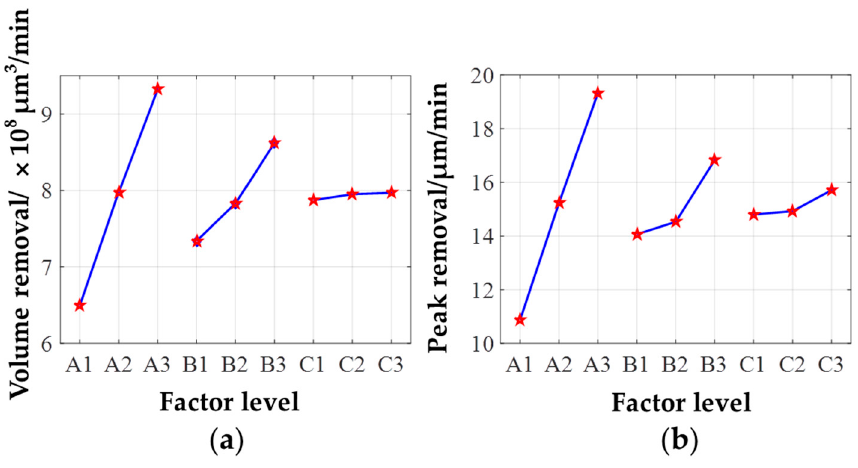
Figure 8. Removal rate under different factor levels: ( a ) Volume removal rate; ( b ) peak removal rate.